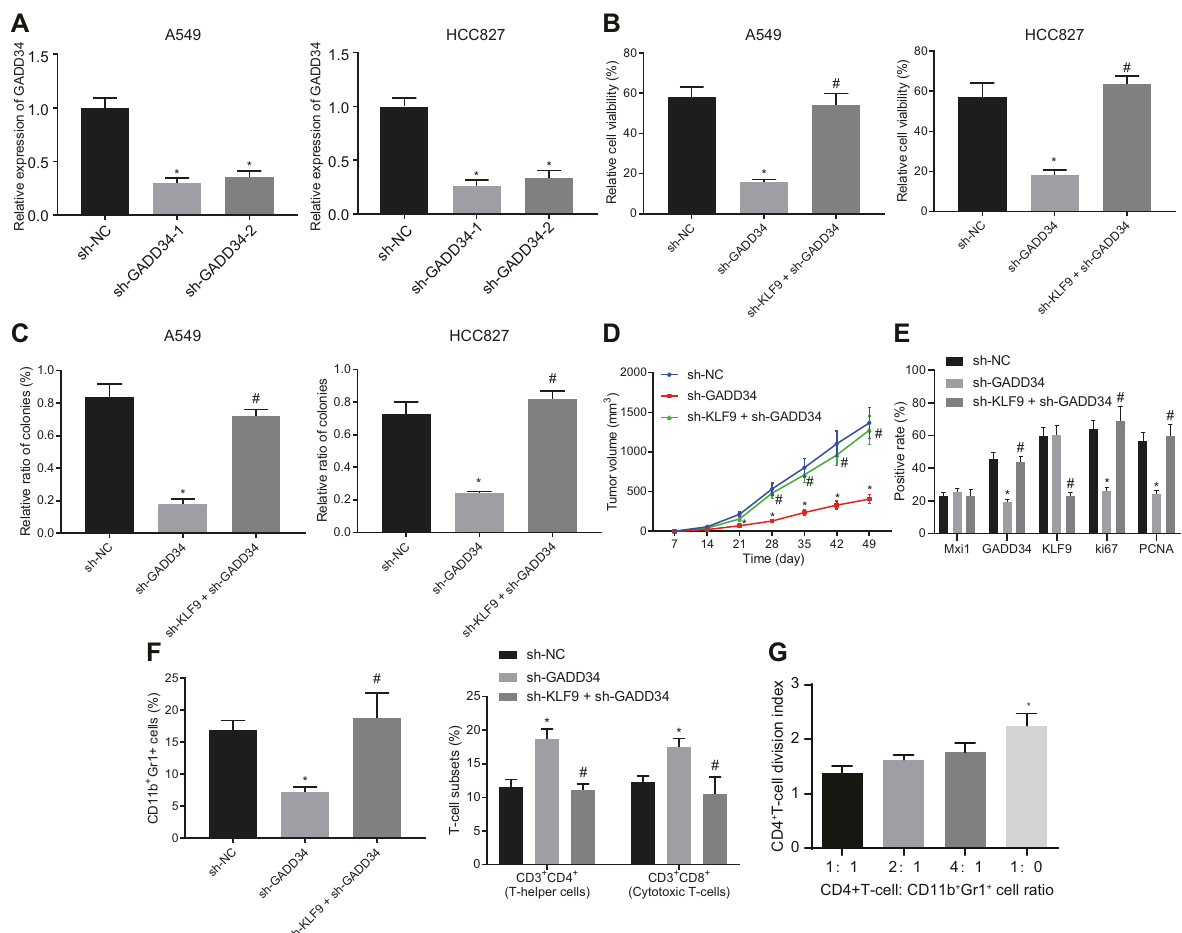
Fig. 7 Knockdown of KLF9 results in GADD34 upregulation, which facilitates tumor growth by recruiting MDSCs to induce immunosuppression. A Result of RT-qPCR detecting the mRNA expression of GADD34 in A549 and HCC827 cells with GADD34 knockdown. * p < 0.05, sh-GADD34. B Result of FACS evaluating proliferation of A549 and HCC827 cells with or without GADD34 knockdown. C Result of colony formation assay investigating the proliferation of A549 and HCC827 cells with or without GADD34 knockdown. D The size of lung tumor formed by HCC827 cells under indicated conditions. E The protein expression of Mxi1, KLF9, GADD34, Ki67 and PCNA protein in the tumor tissues of mice determined with immunohistochemistry. F Result of fl ow cytometry detecting the proportion of the CD11b + Gr + cells, and CD4 + cells, as well as CD8 + T cells. In panel B – F , * p < 0.05, vs. sh-NC. # p < 0.05, vs. sh-GADD34. G Result of CFSE proliferation assay evaluating the cell growth of CD4 + cells co-cultured with CD11b + Gr + cells. n = 10 for mice following each treatment. Cell experiments were conducted three times independently.